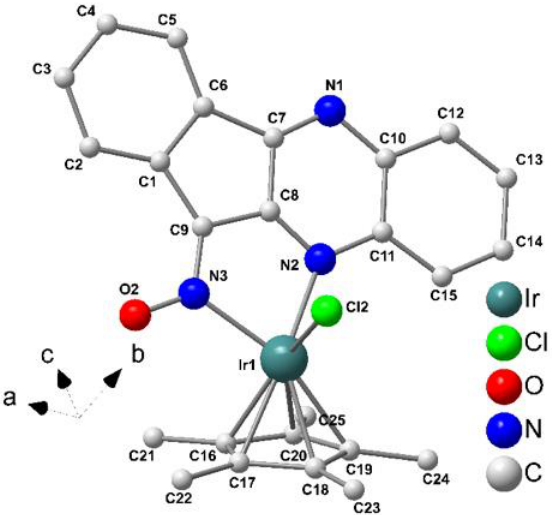
Figure 1. X-ray molecular structure of 1 . Hydrogen atoms are omitted for clarity.